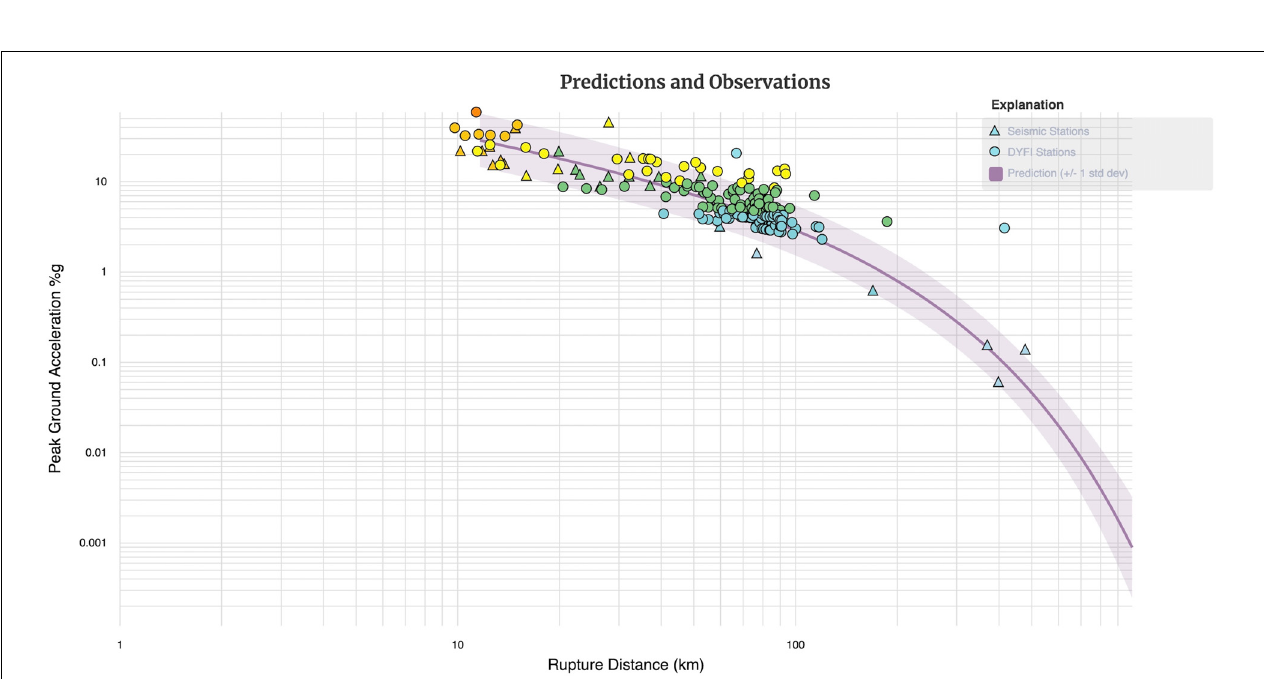
FIGURE 3 | Interactive plot of intensity versus distance from the epicenter for the M6.4 Indios, Puerto Rico earthquake. Scrolling over individual circles would show the data for individual geocoded blocks. The colored trend line is the predicted acceleration based on the ground motion prediction equations used in ShakeMap. The shaded area is one standard deviation above and below the predicted accelerations. Circles correspond to DYFI 1-km geocoded block intensities converted to peak ground acceleration (PGA; Worden et al., 2012). Triangles are seismic stations reporting to ShakeMap. Circles and triangles are color-coded to the intensity scale shown in Figure 1 ; for ShakeMap stations, intensities are converted from ground motion values using Worden et al. (2012) (Source: U.S. Geological Survey).